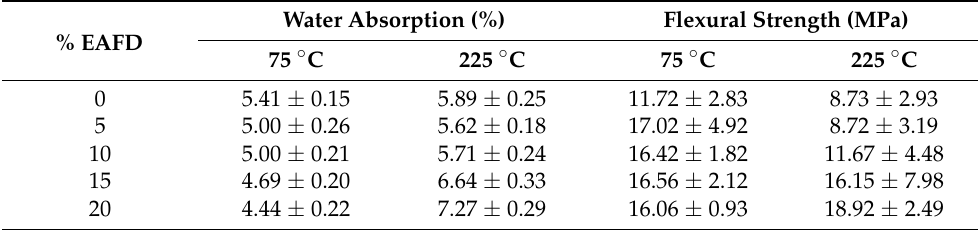
Table 2. Evolution of water absorption and flexural strength for geopolymers with EAFD at 75 ◦ C and 225 ◦ C. Water Absorption % EAFD